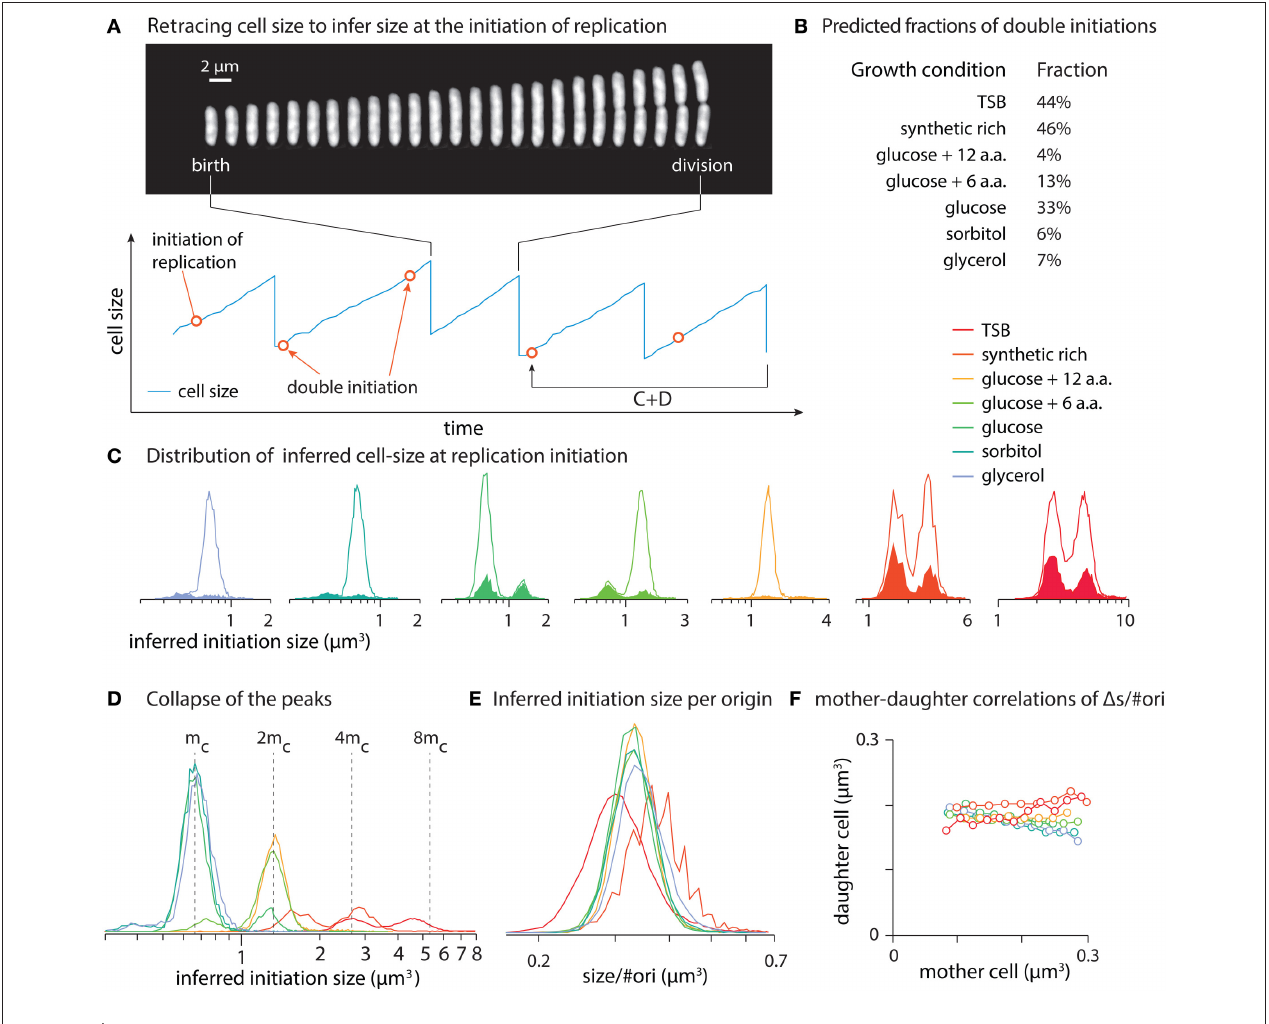
FIGURE 1 | (A) Retracing cell size C + D minutes prior to cell divisions to infer size at initiation of replication. Constancy of C + D predicts some cells have two initiations in one division cell cycle. (B) Fractions of initiations that occur in generations with double initiations. (C) Distributions of hypothetical initiation size can be bimodal. Each panel refers to one growth condition where filled area show the distribution of double initiations and solid lines show the distribution of all hypothetical initiation sizes. (D) The peaks of the distributions in C collapse onto each other. (E) Inferred initiation size per origin of replication from various growth condition collapse onto each other. (F) Mother-daughter correlations of 1 s / # ori (growth per origin of replication), based on inferred initiation moments. Panel (A) is reproduced from Taheri-Araghi et al. (2015a) with permission from